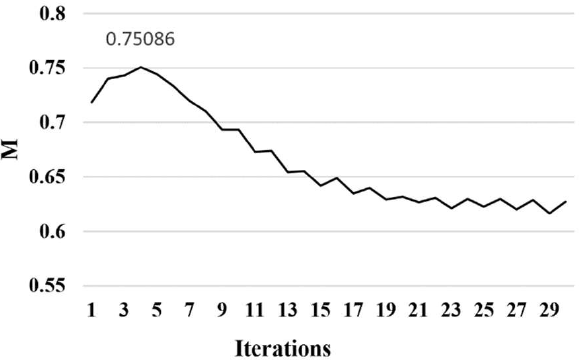
Figure 7. Graph of the number of iterations versus the results.